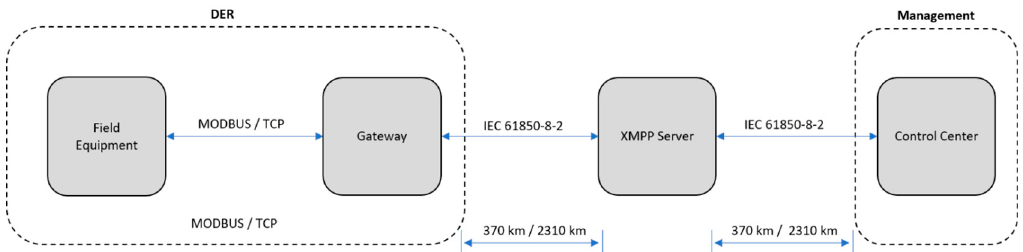
Figure 9. Architecture of test environment.